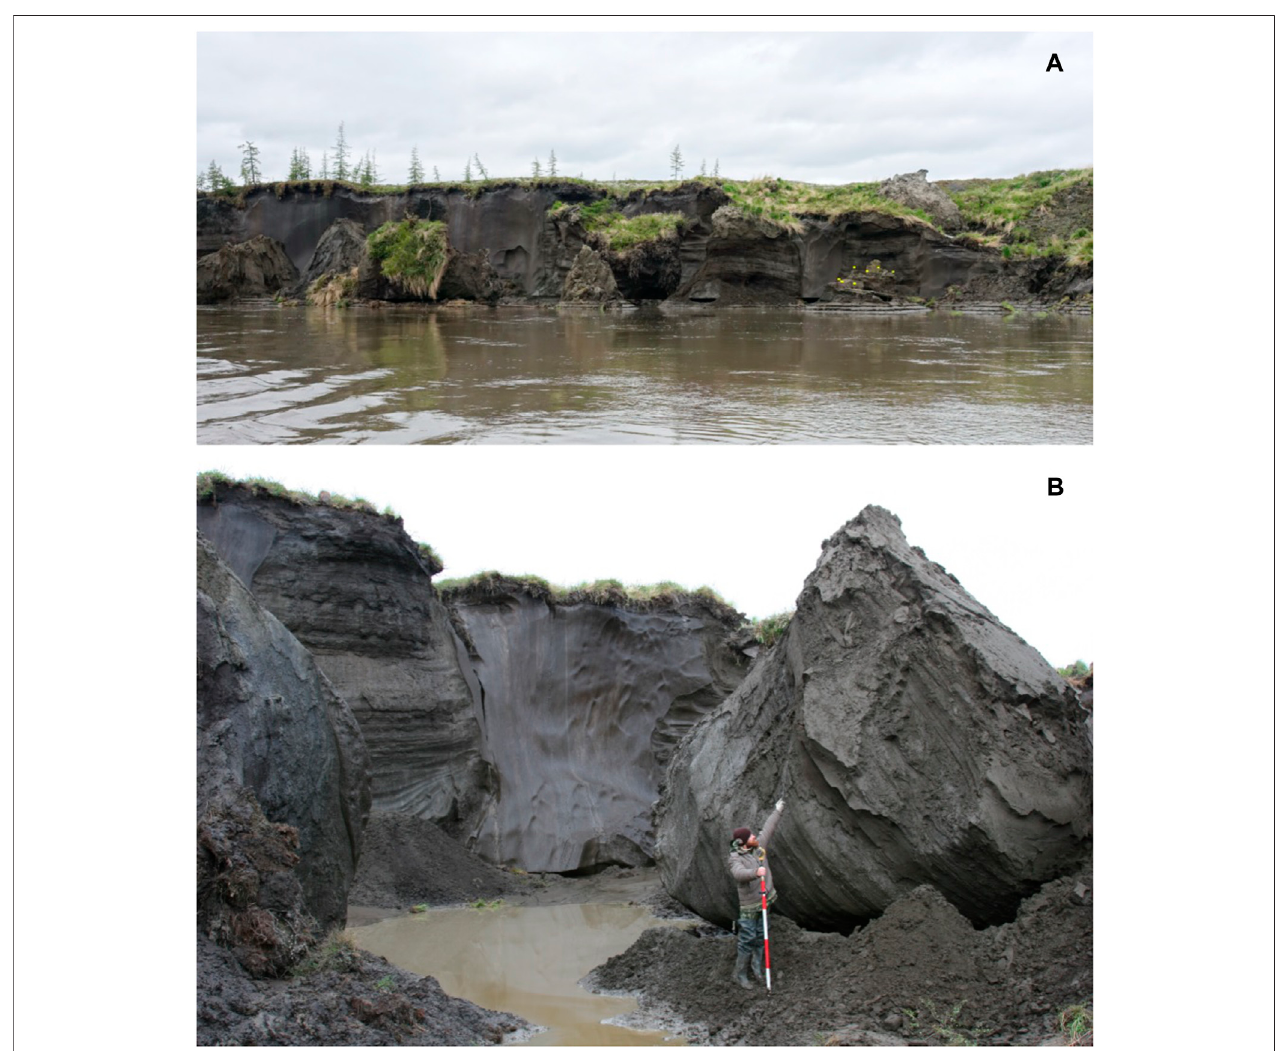
FIGURE 13 | Thermal erosion of the area in the Northern Point area of the Yana site complex: (A) - block collapse at the left bank of the Yana River due to continuouslyhighwaterstand(collapsezoneinbetweenNorthernPointandAreaBoftheYanasite;yellow fl agsseeninthelowerrightcornermarkthewesternborderof the excavation area); (B) - a cultural layer incorporated in the collapsed blocks, its position is indicated by I.G. Kovaltsov (excavations of 2016). Photo: E.Y. Pavlova.